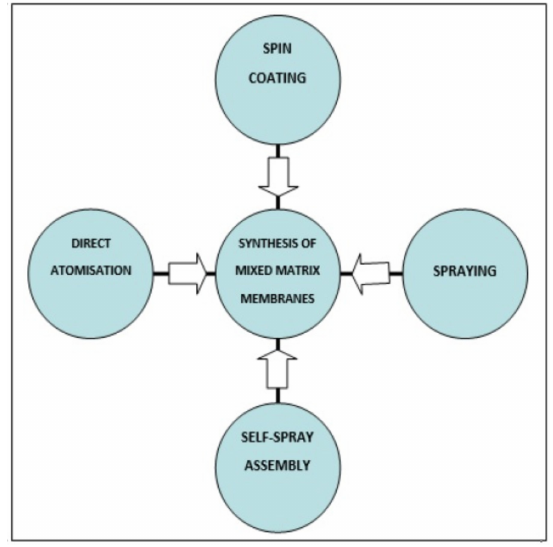
Figure 2. Different synthesis procedures that are used for MMMs.